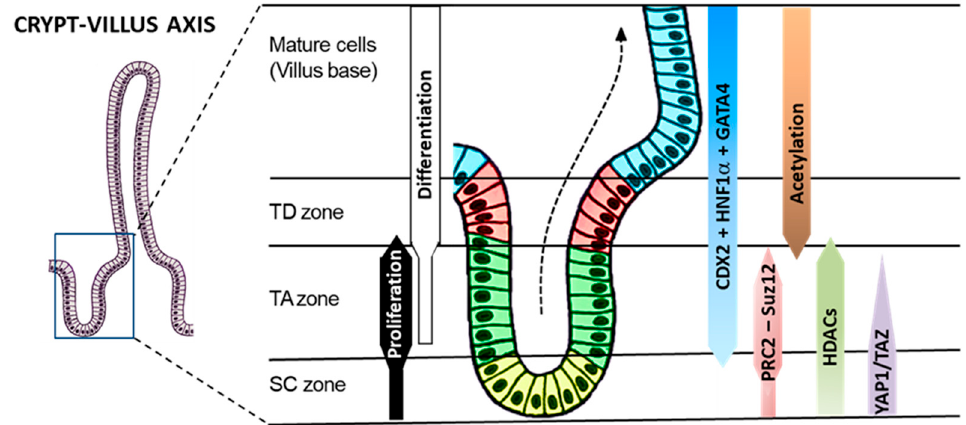
Figure 14. Integration of the molecular mechanisms regulating intestinal differentiation. All steps of intestinal epithelial cell differentiation occur in the crypt so that only fully mature cells reach the villus [1,8]. The crypt is divided into three distinct compartments: the stem cell (SC), the transit amplifying (TA) and terminal differentiation (TD) zones. Intestinal cell differentiation relies on pro-differentiation factors such as CDX2, HNF1 α and GATA4 which are expressed in the TA and TD zones. Goblet cells differentiate in the TA zone, but absorptive cell differentiation is restrained by epigenetic mechanisms involving polycomb repressive complex 2 (PRC2-Suz12) and histone deacetylases (HDACs), which allow proliferation in the TA zone, ensuring a larger proportion of absorptive cells in the TD zone. YAP1/TAZ appear to act at an earlier phase, which involves stemness maintenance and inhibition of both absorptive and secretory lineages through a repression of pro-differentiation transcription factors such as CDX2. Adapted from [1,8].